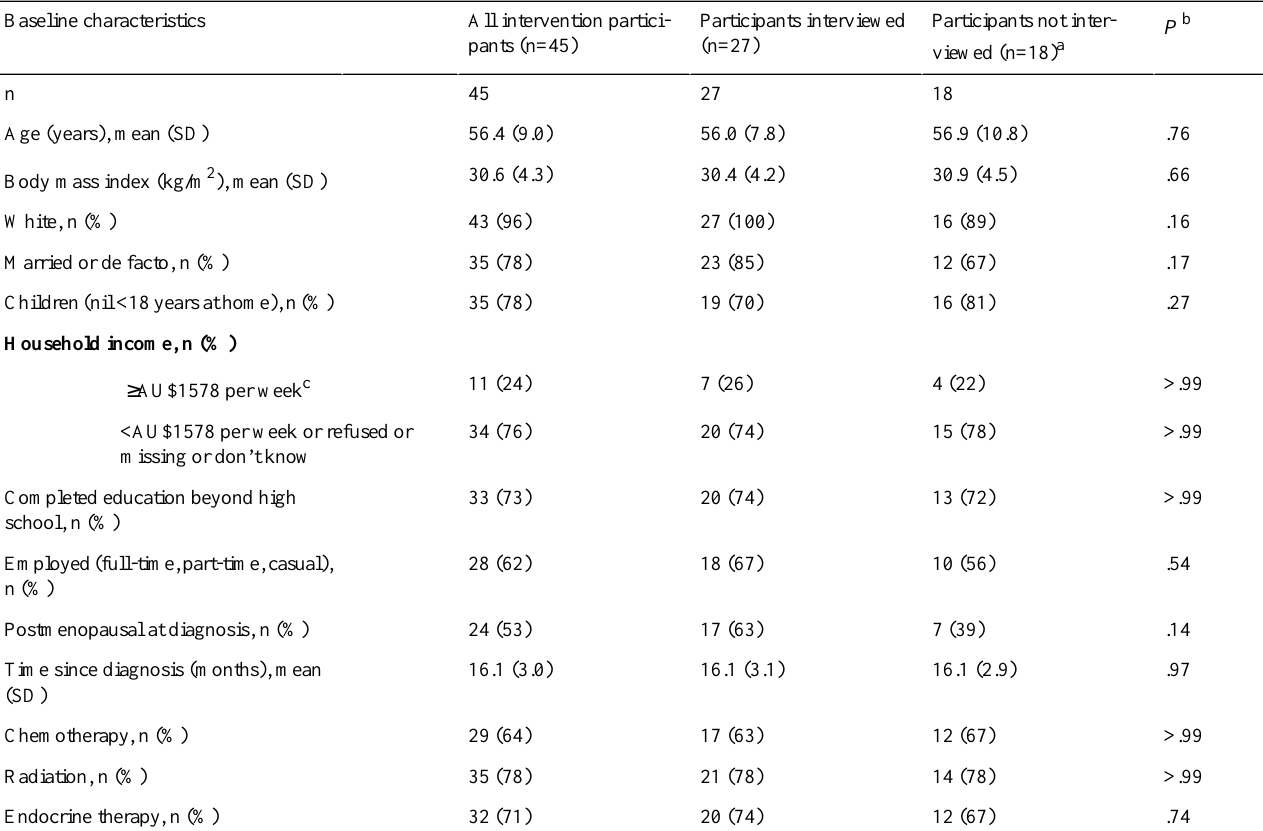
Table 2. Baseline characteristics of all intervention participants (n=45) and those who received extended care and were interviewed for the qualitative analysis